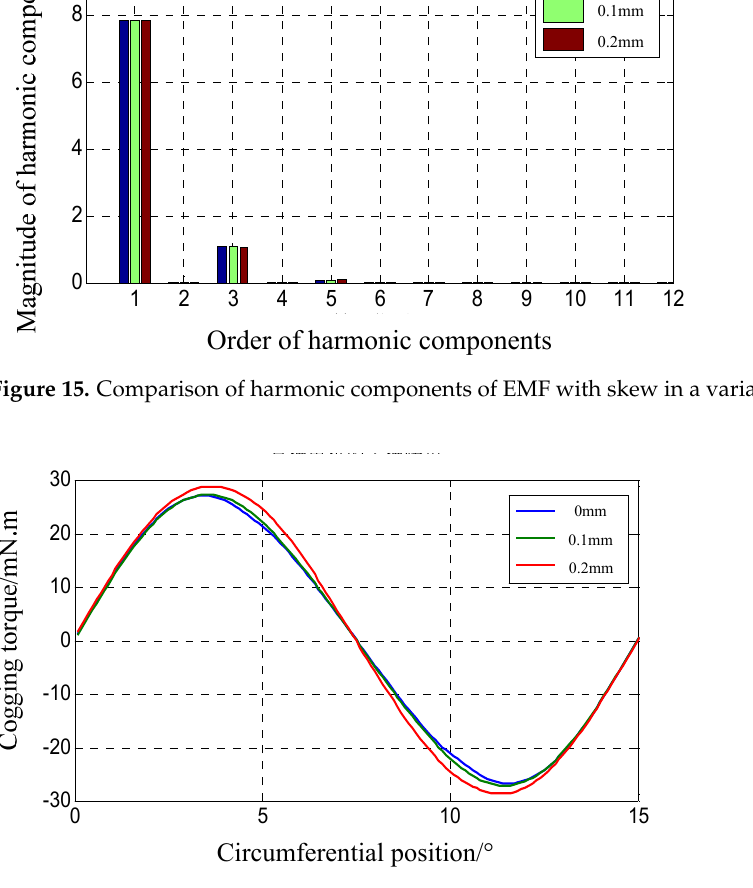
Figure 15. Comparison of harmonic components of EMF with skew in a variable period.